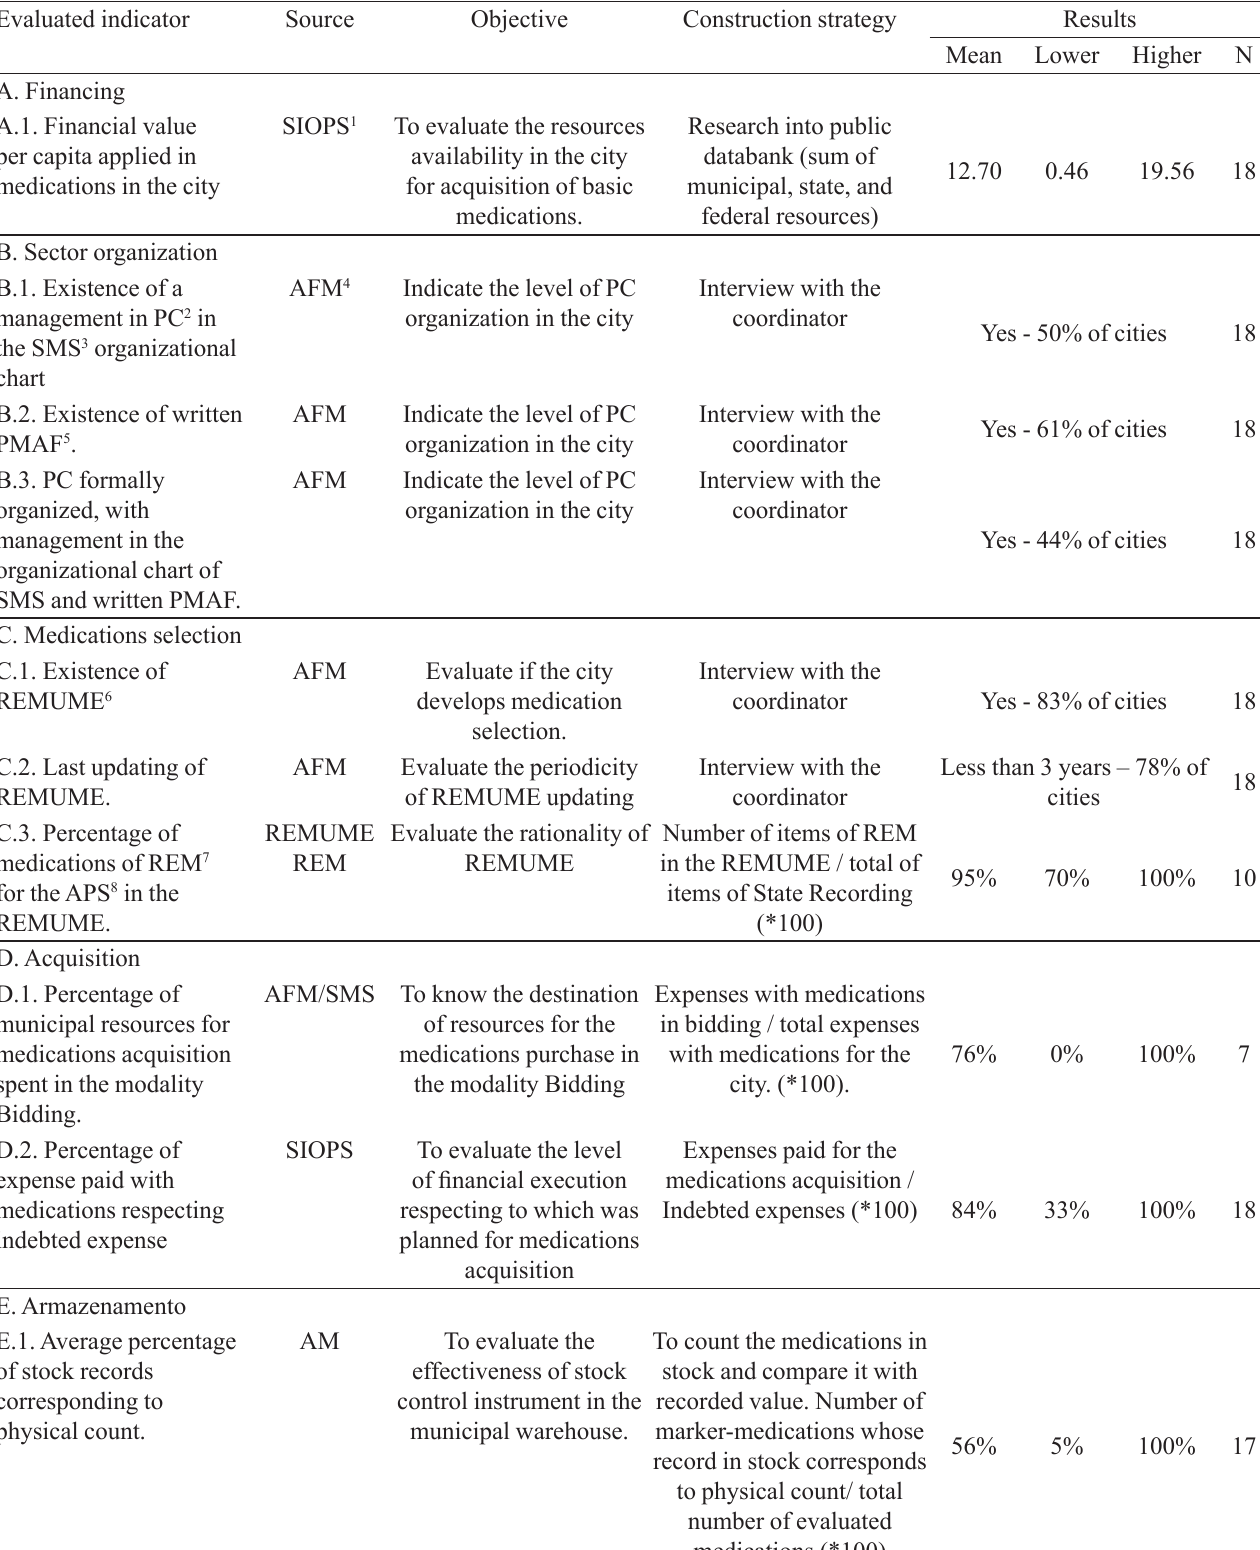
TABLE II – Evaluated indicators, data sources, objectives, construction strategies and abstract of results obtained for every of investigated indicators respecting management of Pharmaceutical Care. Regional Management of Health of Belo Horizonte,